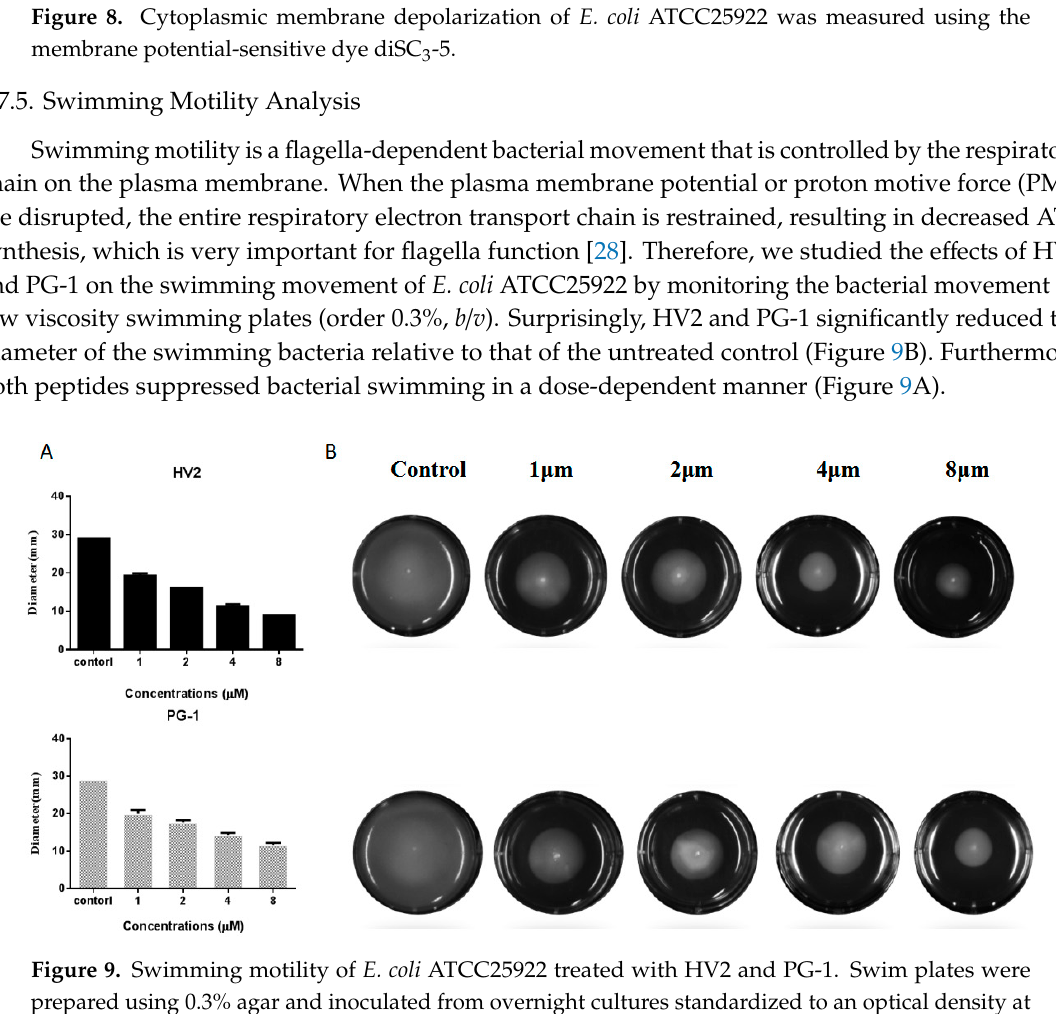
Figure 2. The CD spectra of the peptides. The peptides were dissolved in 10 mM sodium phosphate buffer (pH 7.4) (Blue line), 30 mM SDS (Red line) and 50% TFE (Green line). The mean residue 600 nm of 1.0. Images were taken after 20 h incubation at 37 ◦ C. ( A ) the diameter of the swimming ellipticity was plotted against wavelength. The values from three scans were averaged per sample, bacteria circle; ( B ) swimming bacteria and the peptides concentrations were fixed at 150 μ M.